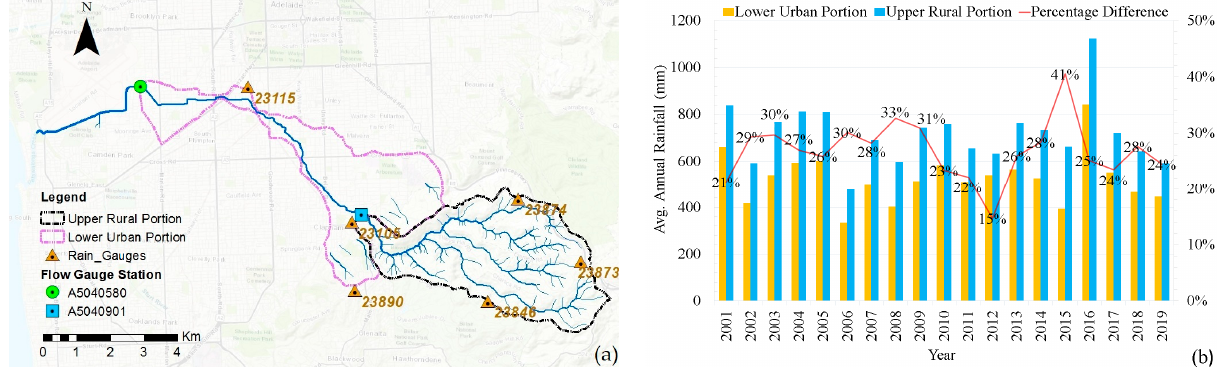
Figure 1. Study Area.